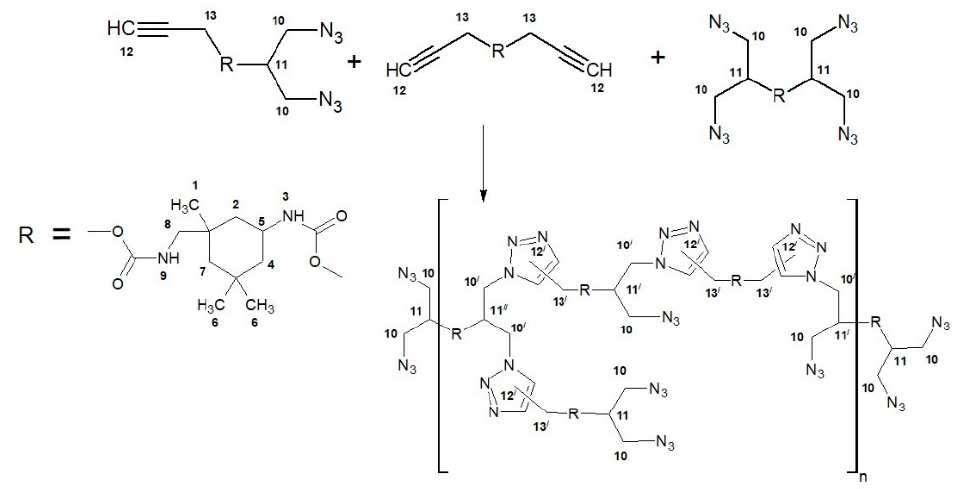
Figure 1. Scheme for the synthesis of hyperbranched polyurethane-triazoles. NMR data for hyperbranched polyurethane-triazoles obtained at ratio [NCO] 0 /[OH] 0 = 1.70: 1 H NMR, ppm: δ = 8.05 (s, H(12 (cid:48) 1,4 ), 7.70 (s, H(12 (cid:48) 1,5 ), 7.51–6.82 (m, H(3), H(9)), 5.50–5.30 (m, H(11 (cid:48)(cid:48) )), 5.29–4.97 (m, H(11 (cid:48) ), H(13 (cid:48) 1,4 ), H(13 (cid:48) 1,5 )), 4.97–4.83 (m, H(11)), 4.71–4.51 (m, H(10 (cid:48) 1,4 ), H(10 (cid:48) 1,5 )), 3.75–3.42 (m, H(5), H(10)), 2.88–2.58 (m, H(8)), 1.77–1.03 (m, H(2), H(4), H(7)), 1.03–0.70 (m, H(1), H(6)). FTIR ATR, cm − 1 : 3327 (NH); 2952, 2926, 2869, 2846 (CH 2 ); 2100 (N 3 ); 1705 (C=O); 1523 (NH); 1460 (triazole).